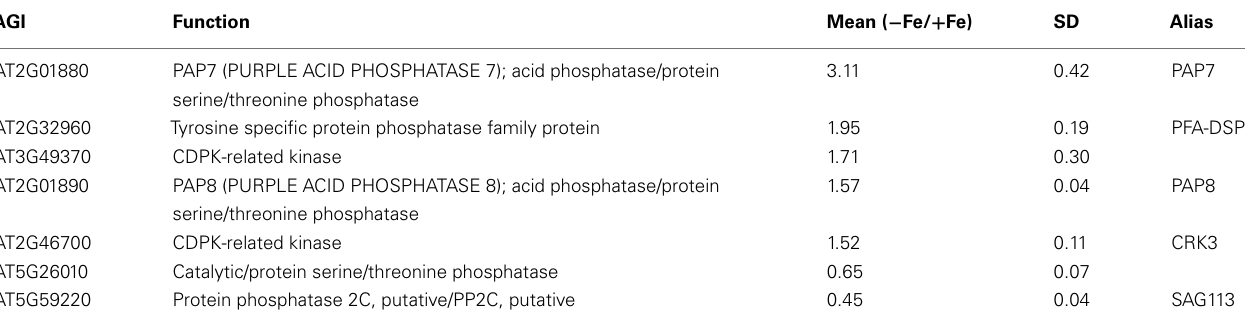
Table 2 | Differentially expressed protein phosphatase genes upon iron deficiency with fold change of more than